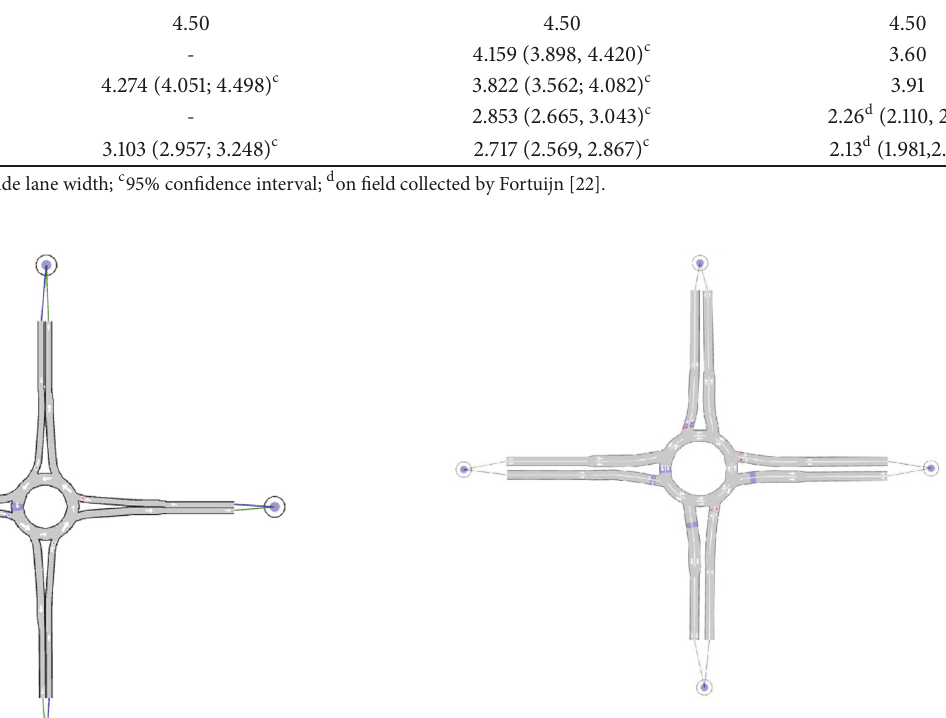
Figure 2: The double-lane roundabout model in simulation envi- ronment.